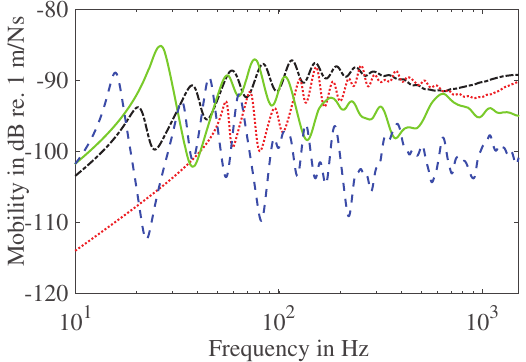
Y |/| Y Y M 1 (-.-), M4 (...), M9 ( — ), and ref |) with ref = 1 m/Ns for M10 ( –